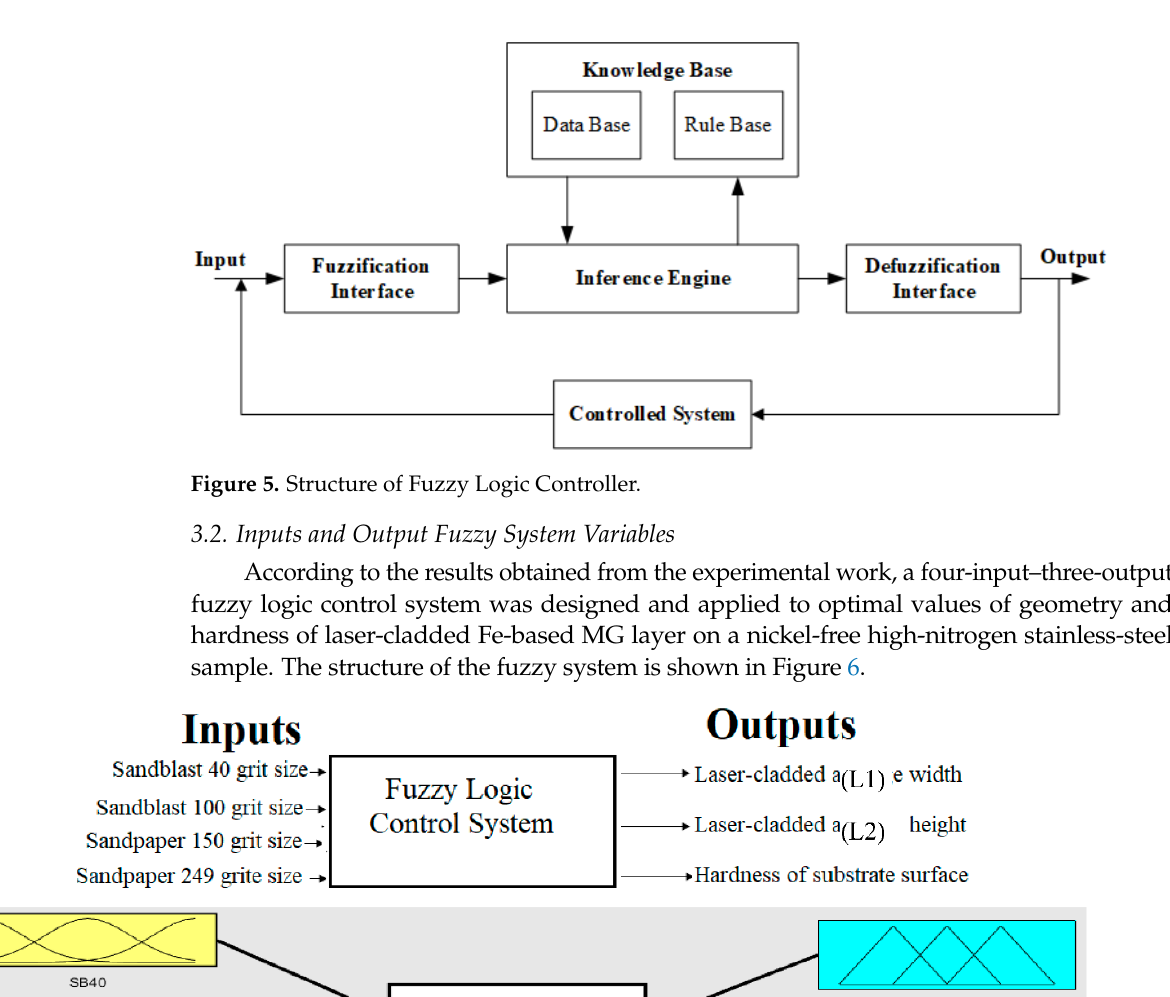
Figure 7. Fuzzy system membership function. Fuzzification in fuzzy is performed by converting a new quantity of inputs into a fuzzy quantity by identifying the deterministic quantities as completely nondeterministic. The triangular membership function used to fuzzify each input to the designed fuzzy sys- tem into three fuzzy values (low, medium, and high) are shown in Figure 8. Triangular membership functions for the fuzzy system inputs (SB40, SB100, SP150, SP240) are shown in Figure 9a–d, respectively. Table 3 explains the range of fuzzy system inputs (sandblast and sandpaper) with three levels: low, medium, and high.